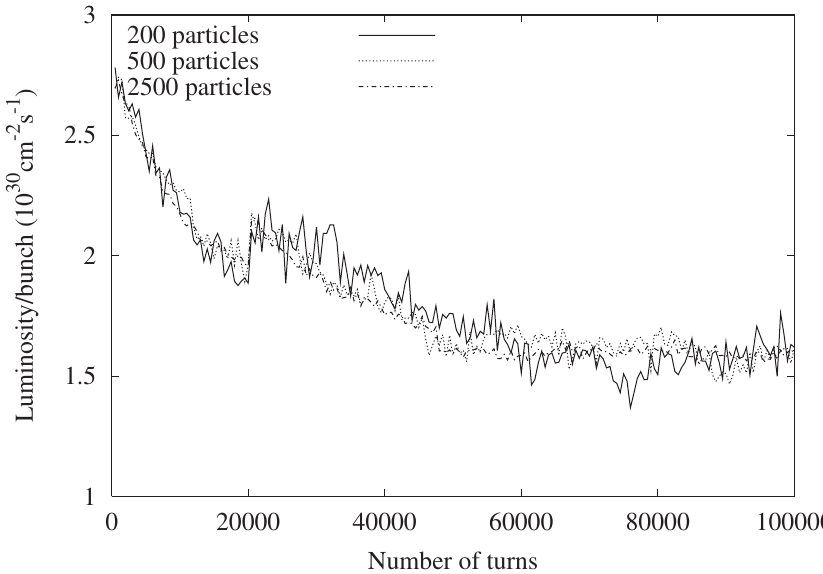
FIG. 6. Luminosity at 2 mA/bunch as a function turn number for different numbers of macroparticles.